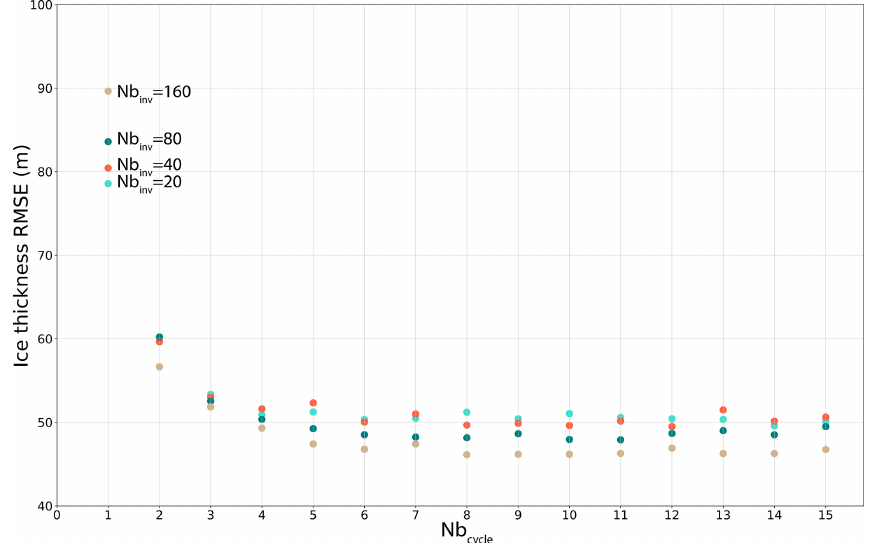
Figure 15. Ice thickness root mean square error with regard to observations from Bamber et al. (2013), in metres, for a fixed Nb free = 200 and four Nb inv values (20, 40, 80, 160), as a function of the number of iterations (Nb cycle ). The experiments use an enhancement factor of